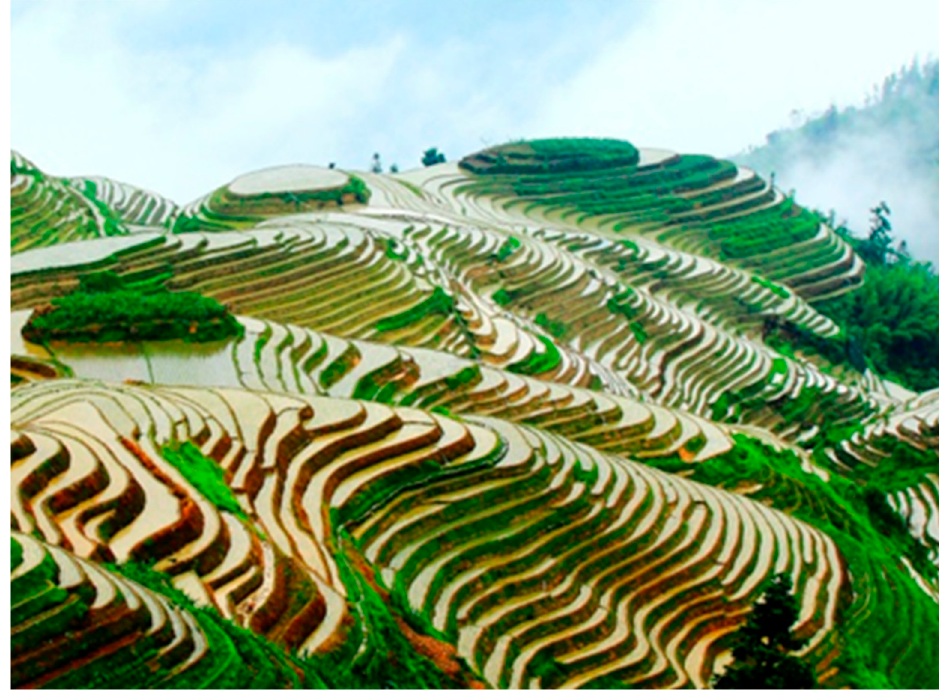
Land 2021 , 10 , x FOR PEER REVIEW Figure 2. Dazhai terraces in spring-sowing season. Figure 2. Dazhai terraces in spring-sowing season.